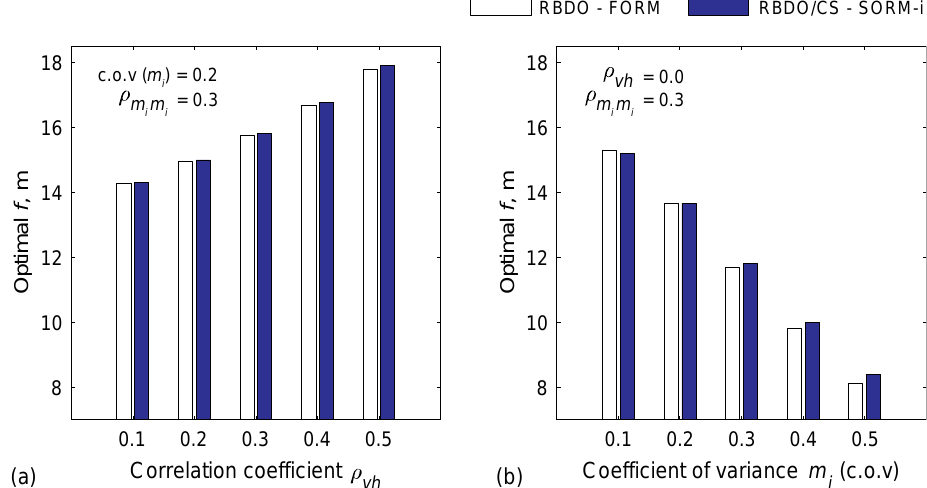
Figure 11. Influence of the changes in the ( a ) correlation coefficients of the forces random variables, and ( b ) coefficients of variation of the moment capacity random variables on the FORM/SORM-i- based RBDO results.